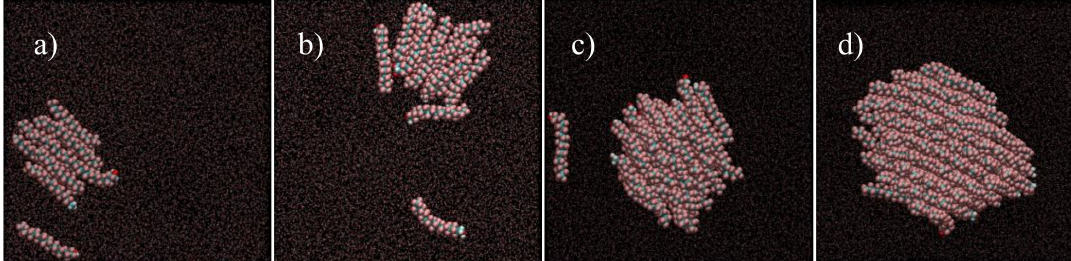
Figure 5. Representative top-view simulation snapshots of Langmuir films of F18OH at the surface of water, in the limit of very low surface density: ( a ) 8.28 nm 2 / molecule; ( b ) 6.37 nm 2 / molecule; ( c ) 2.59 nm 2 / molecule; ( d ) 1.29 nm 2 / molecule. The simulation boxes contain 10, 13, 32 and 64 alcohol molecules, respectively; water molecules are represented as dots for